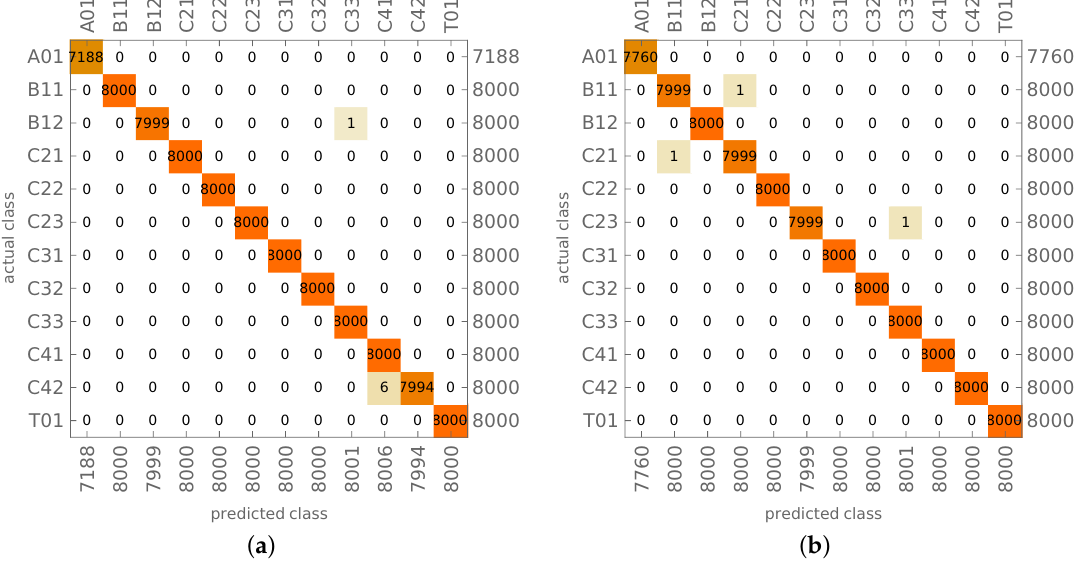
Figure 5. The results of CNN- O mode shapes identification: ( a ) learning, ( b ) testing. It has to be noted that in some selected cases, a result classified as incorrect in compar- ison with the reference analytical procedure may be in fact correct, because the analytical procedure also may incorrectly identify the mode shape in question. However, such cases are few and do not affect the accuracy of the CNN procedure.